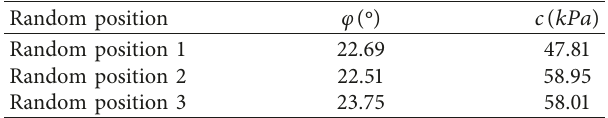
Figure 12: Mohr’s circle and strength envelope lines of samples under different random positions: (a) random position 1; (b) random position 2; (c) random position 3. Table 6: Strength indexes of soil-rock mixture under different random